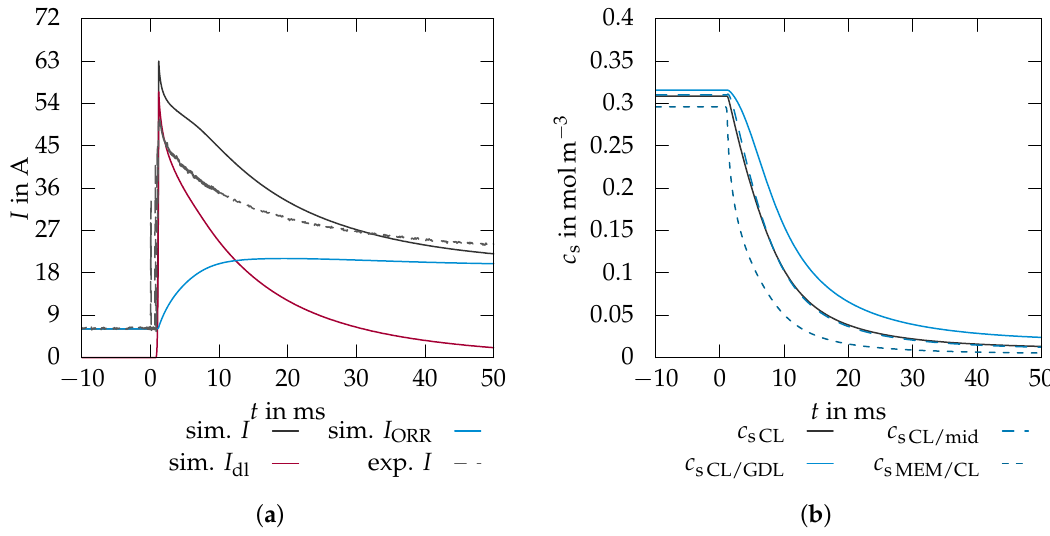
Figure 14. ( a ) Current contributions from the simulation (solid) and the measurement (dashed) of the total current for a stationary load of 0.1 Ω prior to the SC. ( b ) Average oxygen concentration at the centre of an agglomerate in the CL from the simulation with 0.1 Ω stationary load prior to the SC at different locations in the